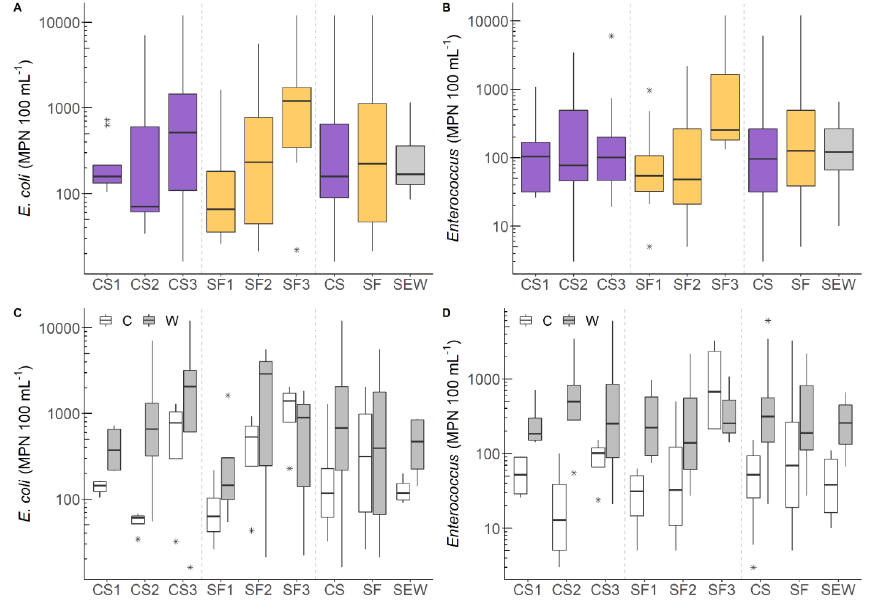
Figure 2. Concentrations of Escherichia coli and Enterococcus spp. from watersheds grouped by wastewater treatment approach ( A , B ) and comparison of cold ( C ) vs. warm (W) months showing increased fecal indicator bacteria during warmer months ( C , D ). Pooled data are shown for each group as CS = conventional septic; SF = sand filter; SEW = sewer. The asterisks (*) denote outliers.